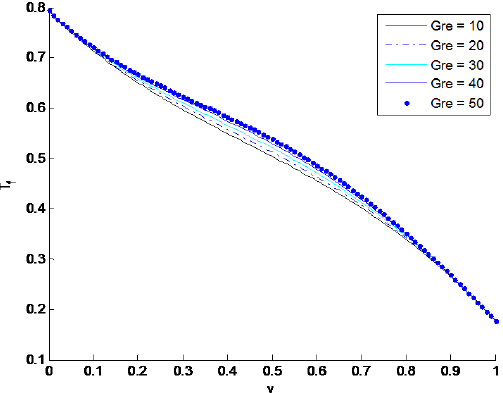
Figure 8: Velocity profile for different values of variable viscosity λ